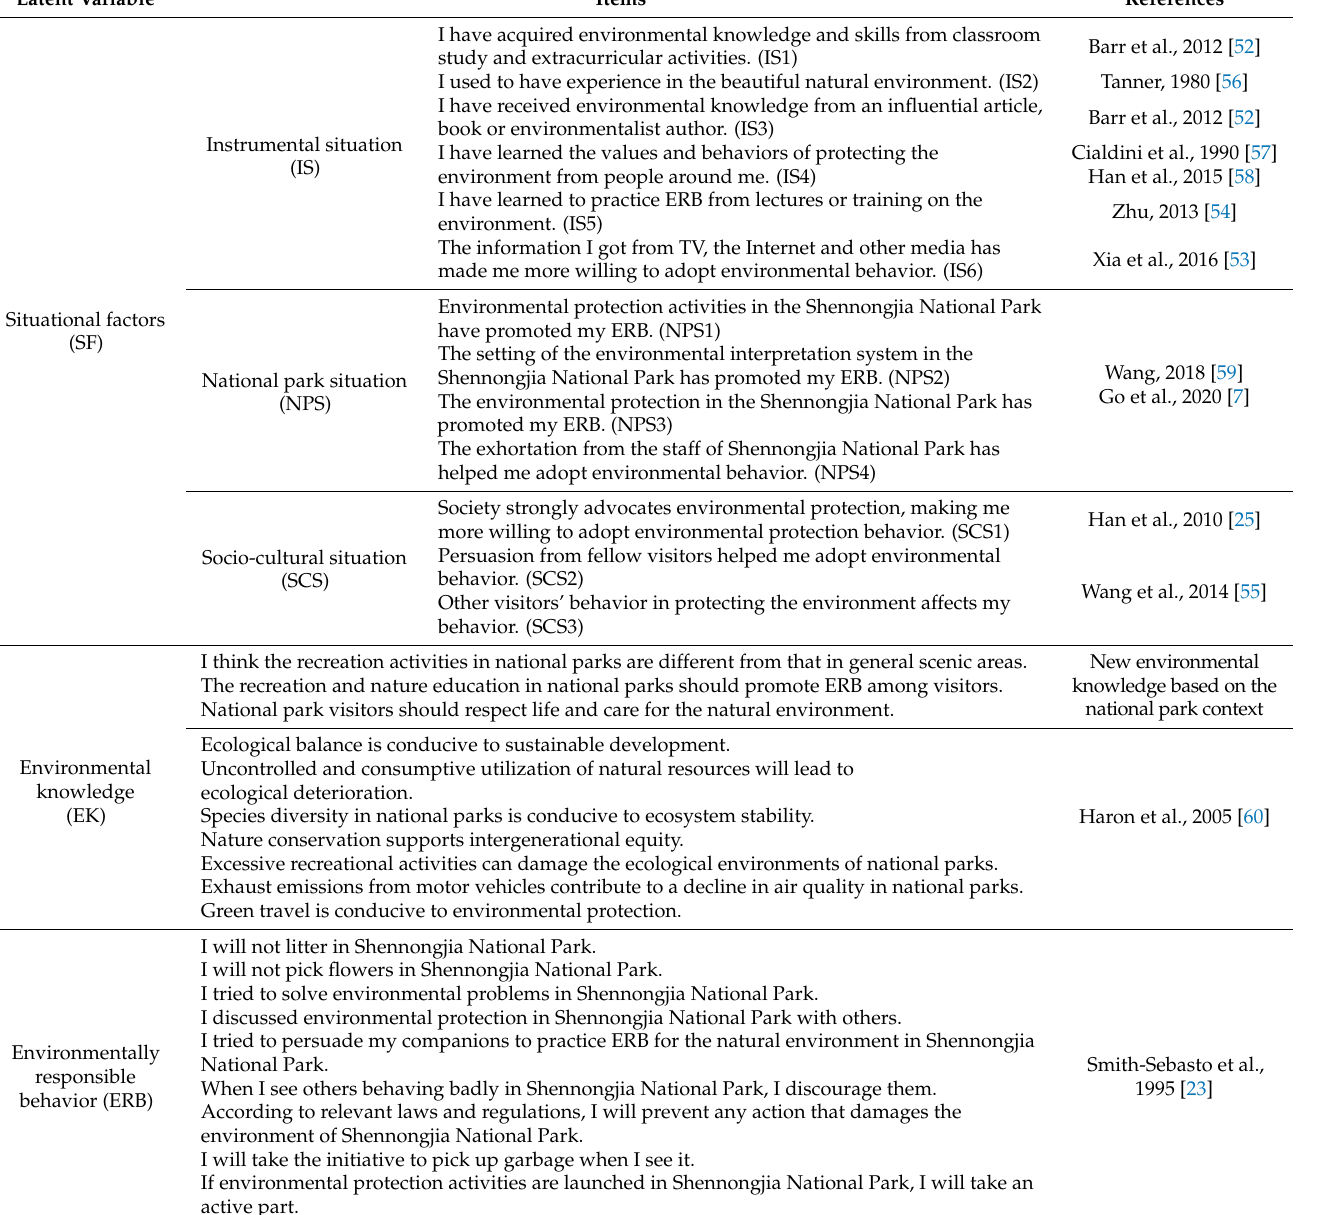
Table 1. Questionnaire